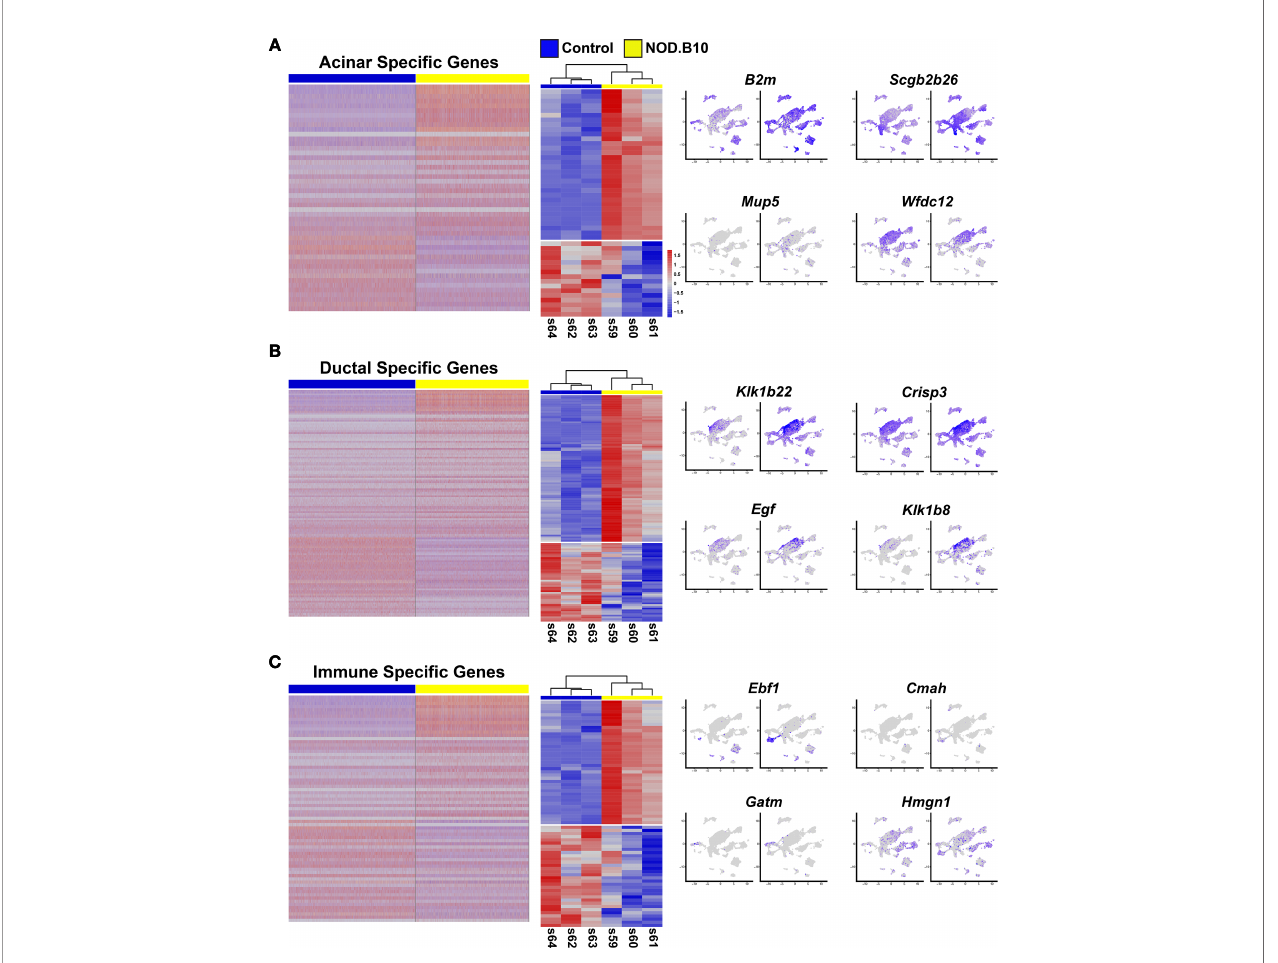
FIGURE 6 | Comparative Analysis of the Bulk RNA-seq and Single Cell RNA-seq Datasets. (A) Heatmap visualization of DEGs identi fi ed in scRNA-seq datasets (left panel) which are common with the bulk RNA-seq datasets (middle panel) with representative feature plots (right panel) of genes in the acinar, ductal (B) , and immune cell clusters (C)